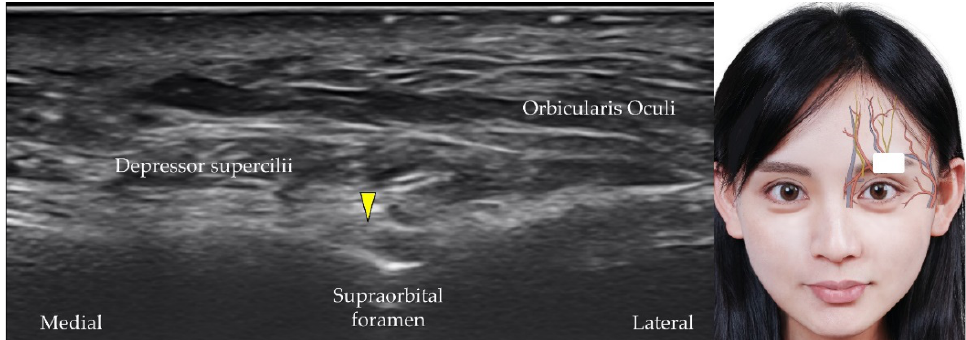
Figure 7. Ultrasound imaging of the supraorbital nerve (yellow arrowhead) . White square , footprint of the ultrasound transducer.